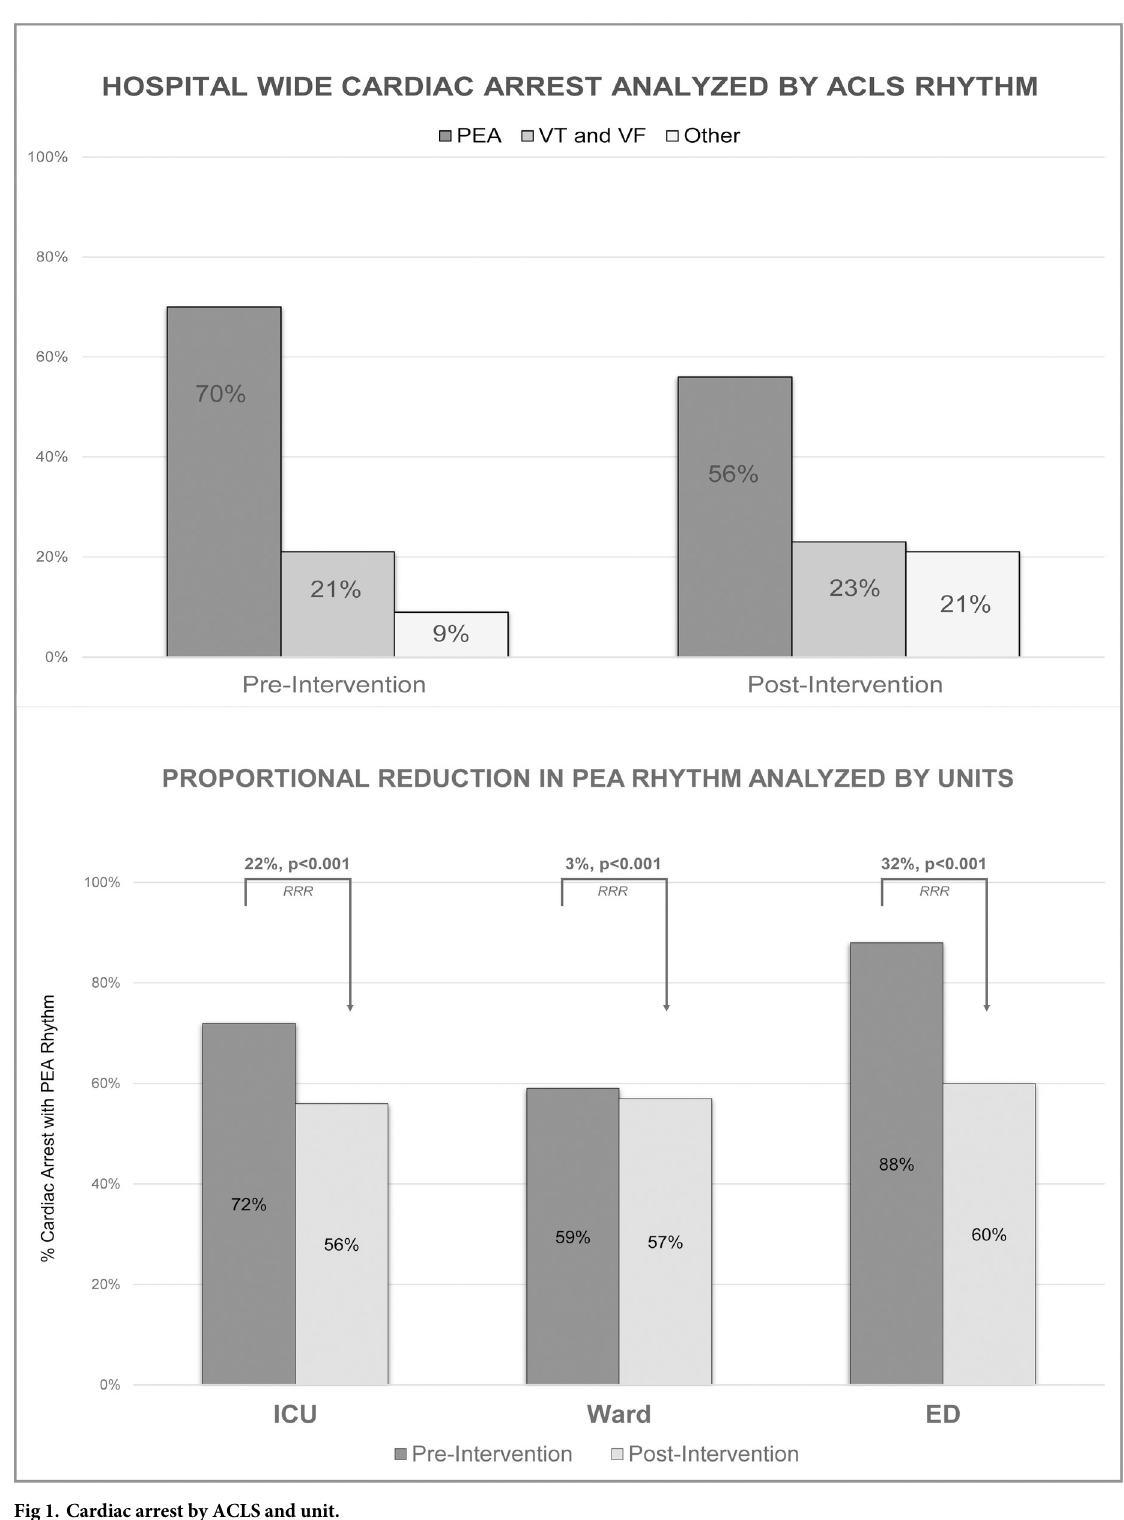
Fig 1. Cardiac arrest by ACLS and unit.